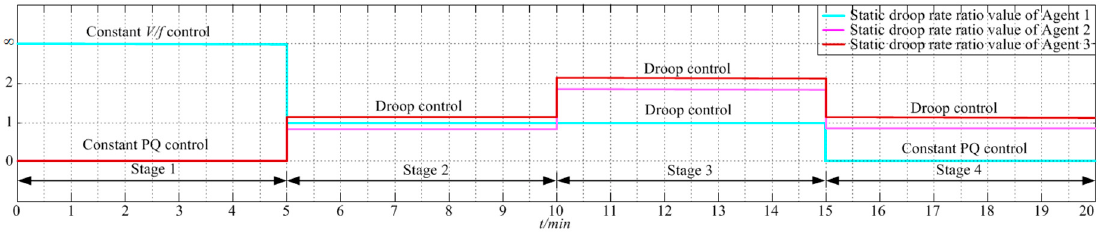
Figure 7. Static droop rate ratio of DGs.